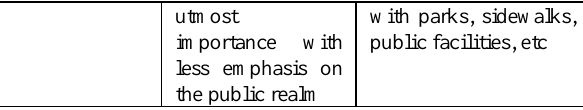
Table 1: Comparison of sprawled growth and smart growth